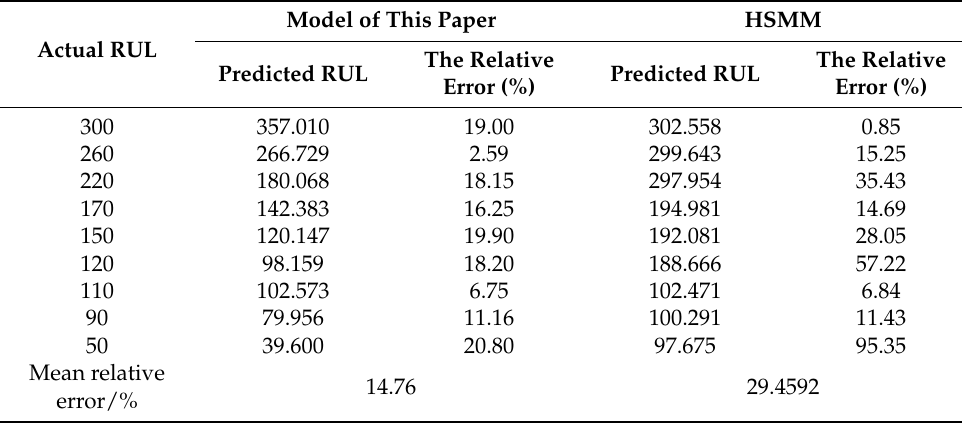
Table 8. Relative error analysis of the predicted